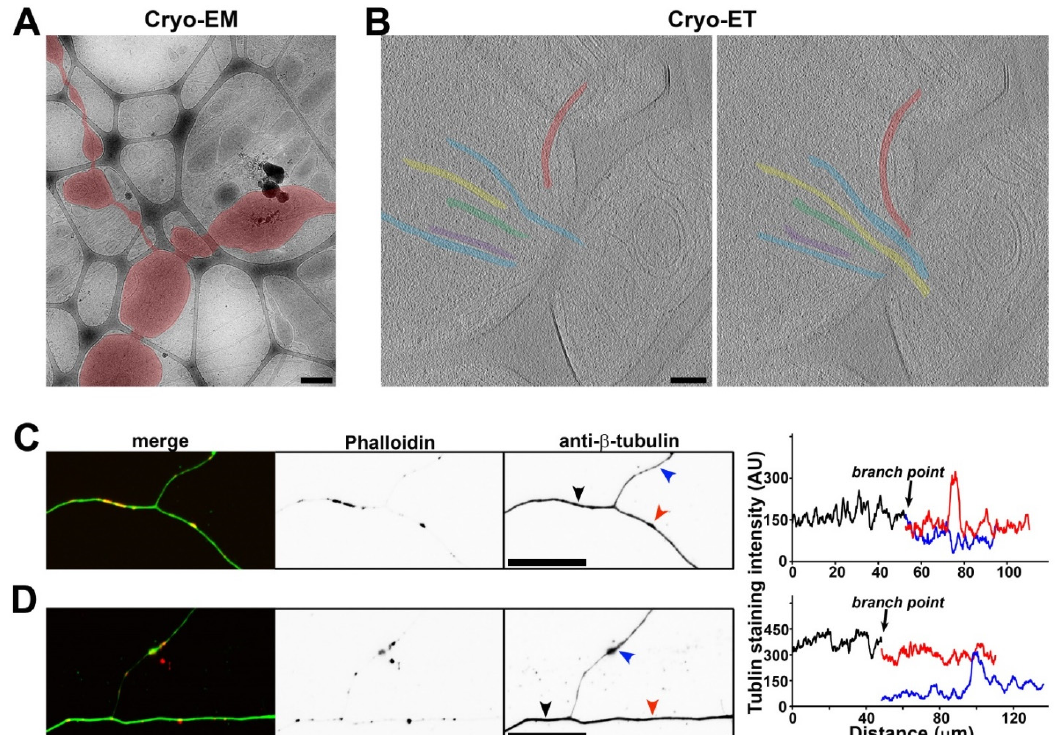
Figure 6. Unequal splitting of MTs into two daughter branches. ( A ) Low-magnification Cryo-EM image of an axon branch point. The axon is highlighted in red. ( B ) Two slices from the Cryo-ET tomogram of the axon branch point in ( A ). Five out of six MTs (in different colors) extended into one daughter branch, while one MT (in red) extended into the other daughter branch (the thinner